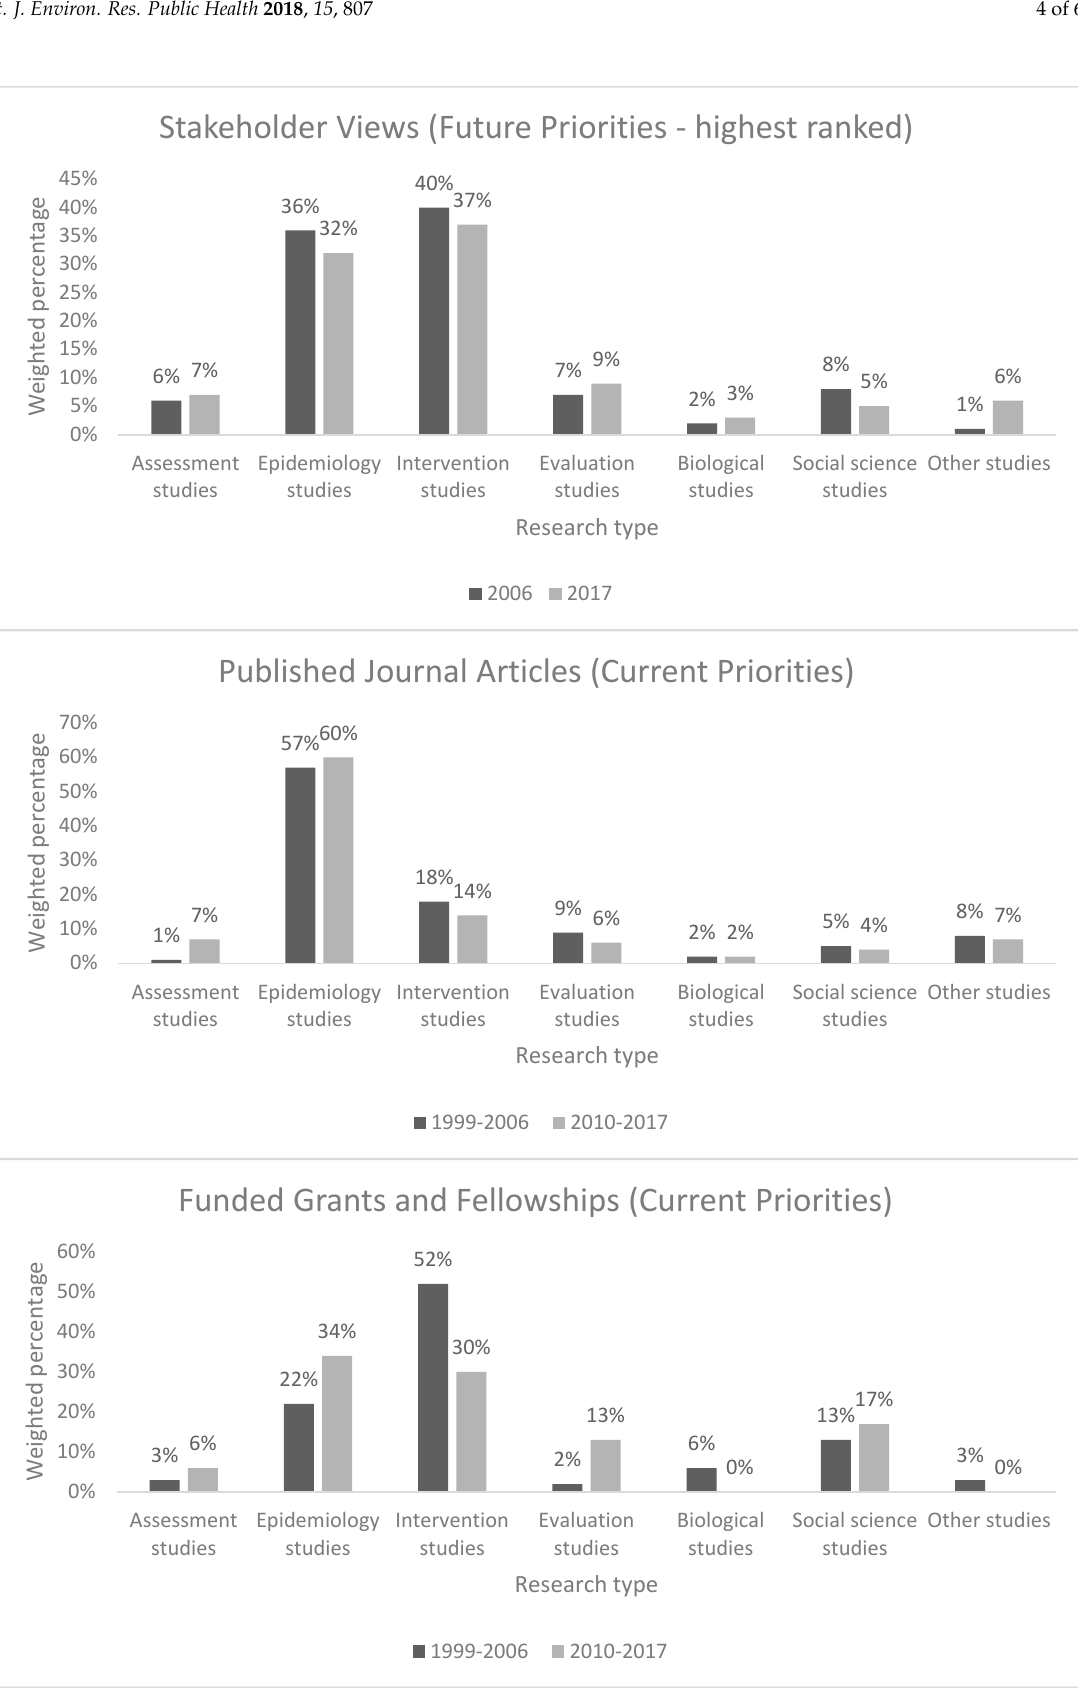
Figure 1. Research priorities identified in published journal articles, funded grants and fellowships, and stakeholder views, by research type (for periods 1999–2006 and 2010–2017).